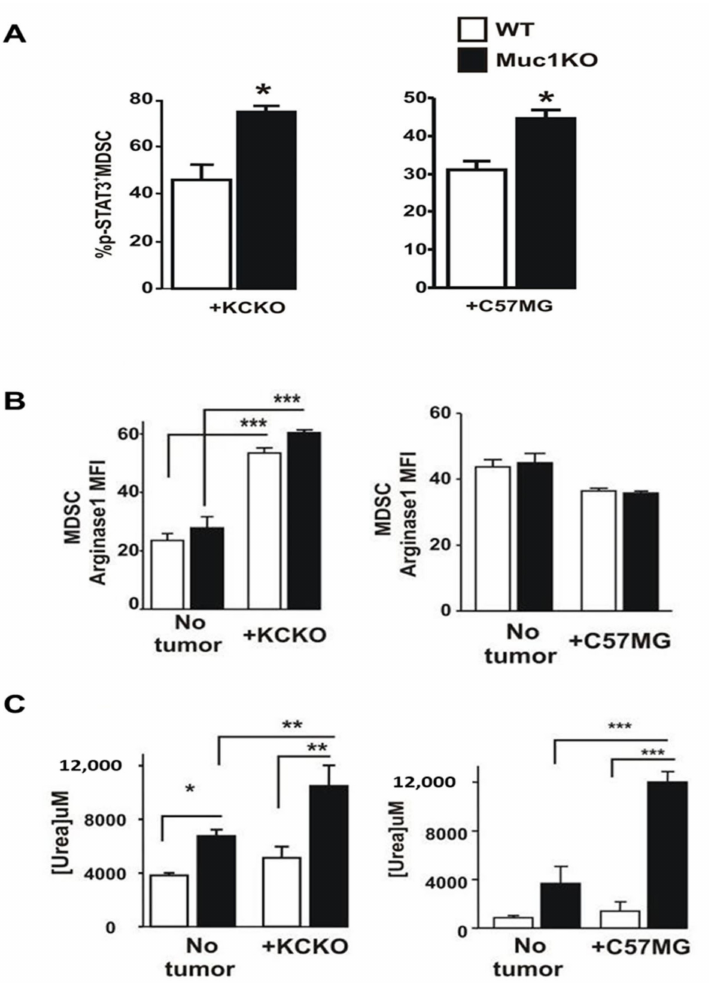
Figure 3. Phenotypic characterization of MDSCs in the BM of healthy and tumor bearing WT and Muc1KO mice. ( A ) Splenocytes from tumor bearing WT and MUC1KO mice were isolated and labeled with antibodies against Gr1, CD11b, and pSTAT3. pSTAT3 + cells were determined on Gr1